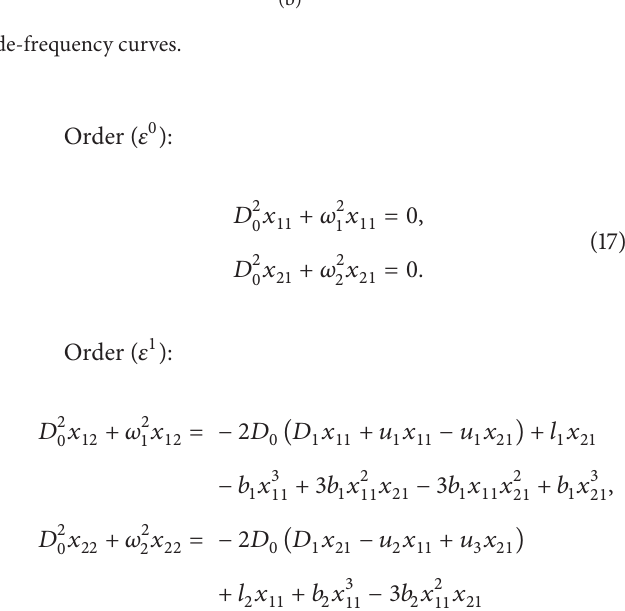
Figure 4: Amplitude-frequency